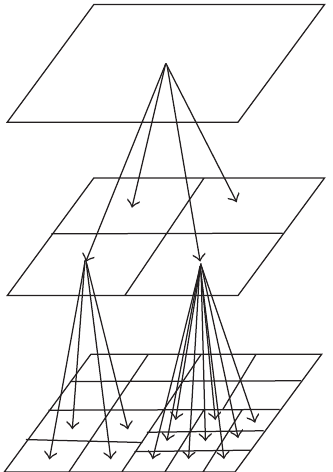
Figure 2: The hybrid tree structure in the 2D case.